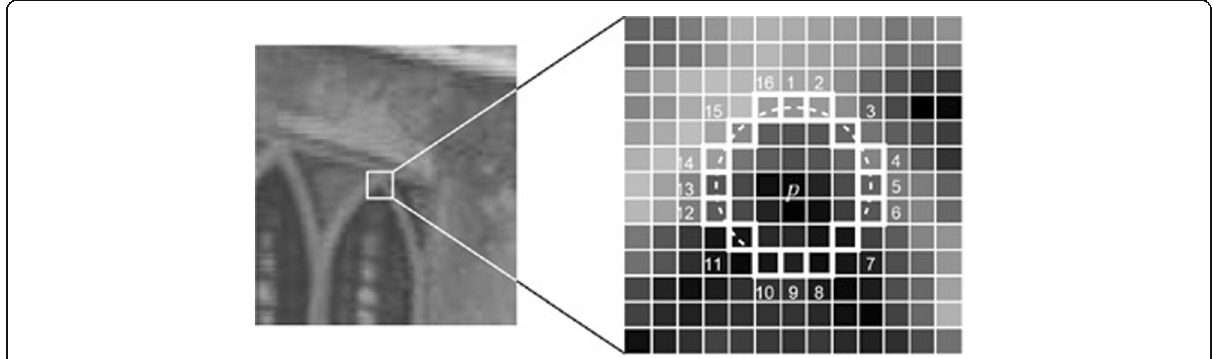
Fig. 1 FAST feature detection pixel number and detection